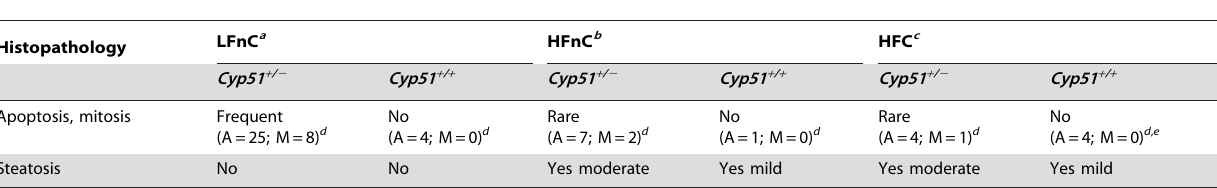
Table 2. Summary of the liver